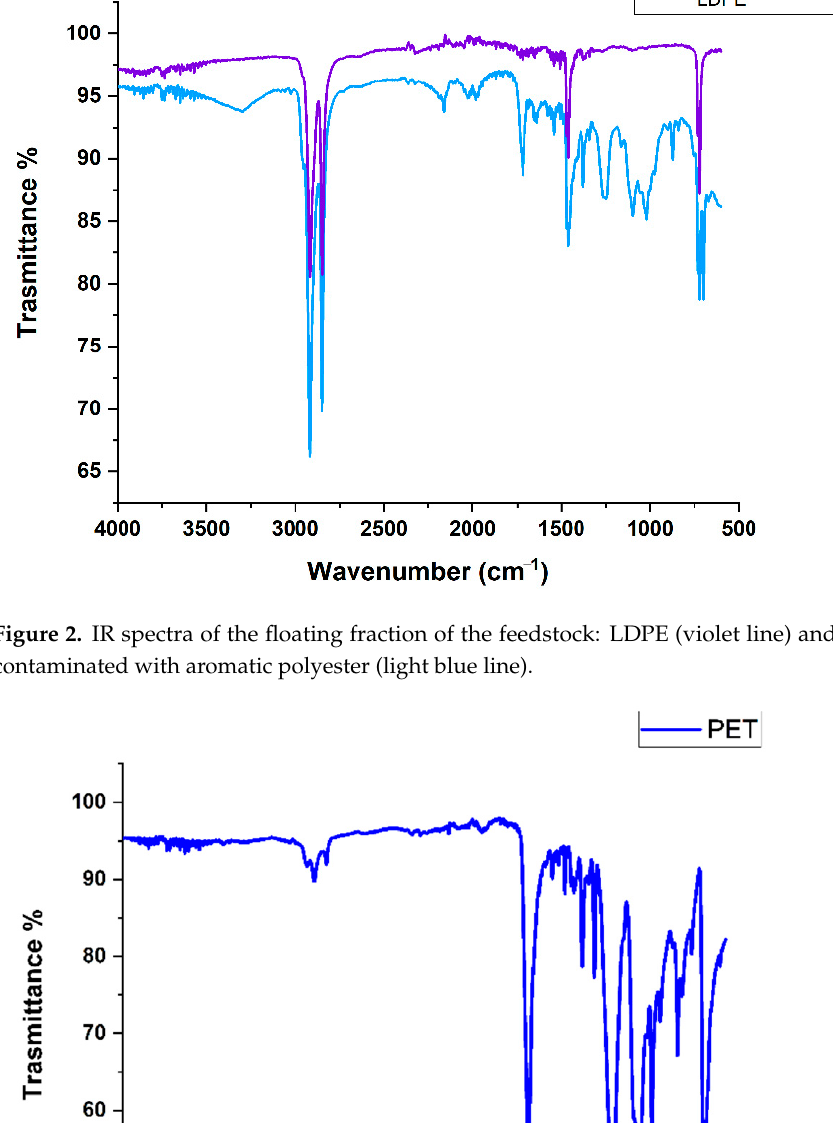
Figure 3. IR spectrum of PET presents in the sunken fraction of the feedstock. The elemental composition on the dry basis of the feedstock and the two fractions obtained through the separation in water is given in Table